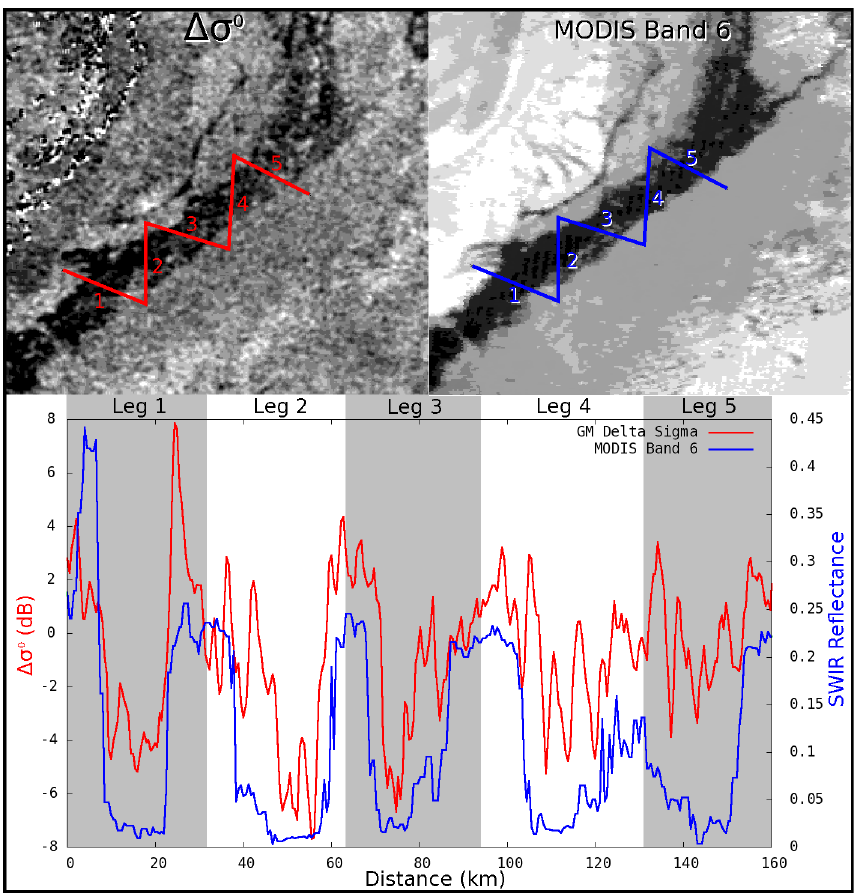
Fig. 10. Comparison of value profiles of 1σ 0 (top-left image, red profile) and MODIS Band 6 (1628–1652nm) (top-right image, blue profile) from a section of the flooded Indus on 10 August